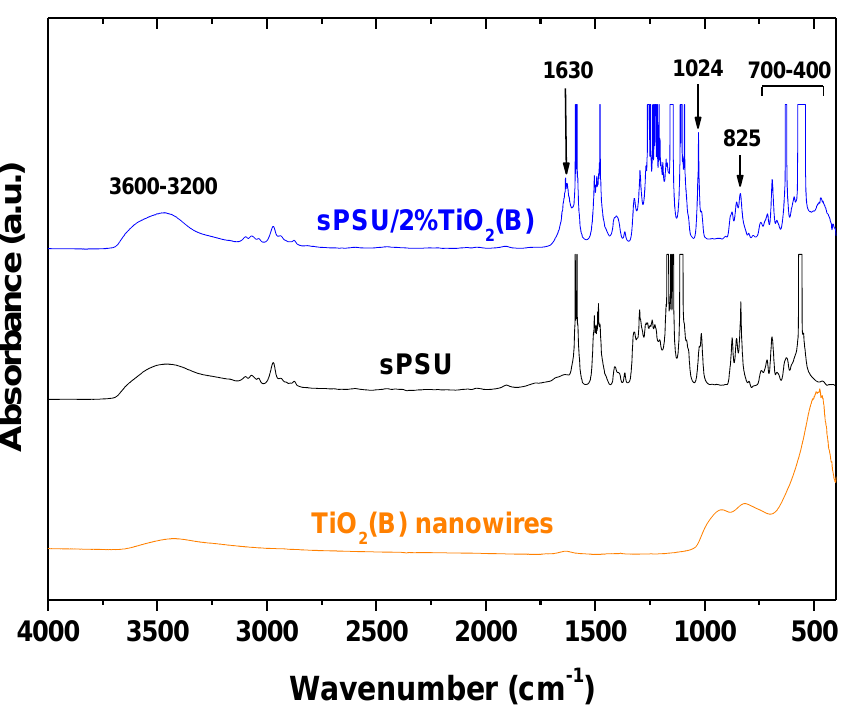
Figure 5. FTIR spectra of TiO 2 (B) nanowires, sPSU and doped sPSU/2%TiO 2 (B) composite mem- branes. The FTIR peak assignments are collected in Table S1.